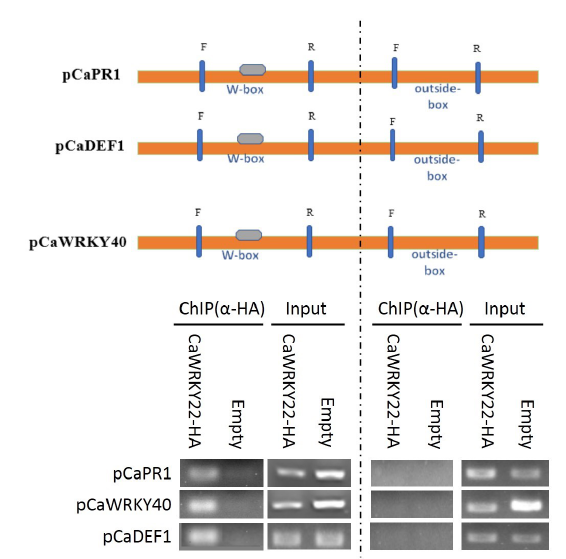
Figure 6. CaWRKY22 binds to the W-boxes of different marker genes as detected by chromatin immunoprecipitation (ChIP) analysis. CaWRKY22-HA was transiently overexpressed in pepper leaves, the chromatin was isolated, the DNA–protein complex was immunoprecipitated using anti-HA antibodies and adjusted to the same concentration. PCR was performed using primer pairs based on the sequence flanking the W-box within the promoters of CaPR1 , CaDEF1 , and CaWRKY40 . “F” stands for forward while “R” represent